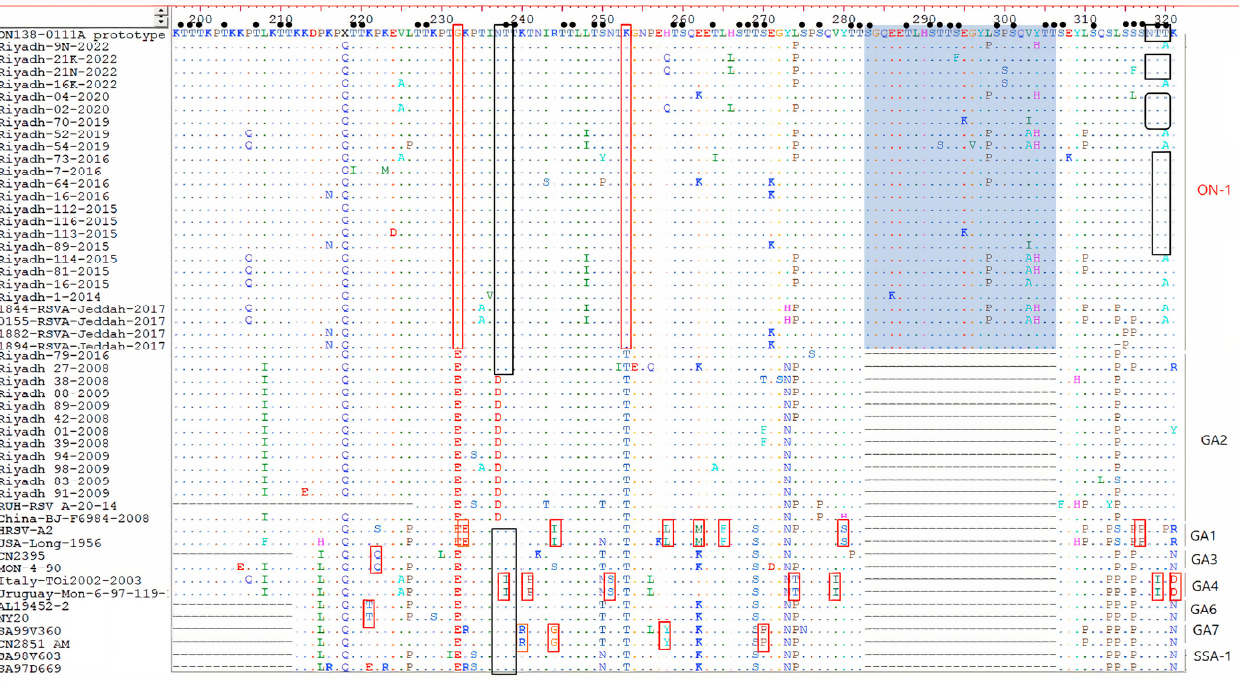
Figure 2. Alignment of deduced AA sequences of the 2nd HVR of the G genes of HOPV group A. The AA positions corresponded to AA positions of the relative to the sequences of prototype ON1 strain. Different AAs are marked in different colors, identical residues are presented by dots. The original and duplicated amino-acid region are shown in the green rectangles. Red rectangles color = the AA residues specific to genotype. Predicted N-glycosylation sites are enclosed in black rectangles. Small filled circles correspond to predicted O-glycosylation sites.